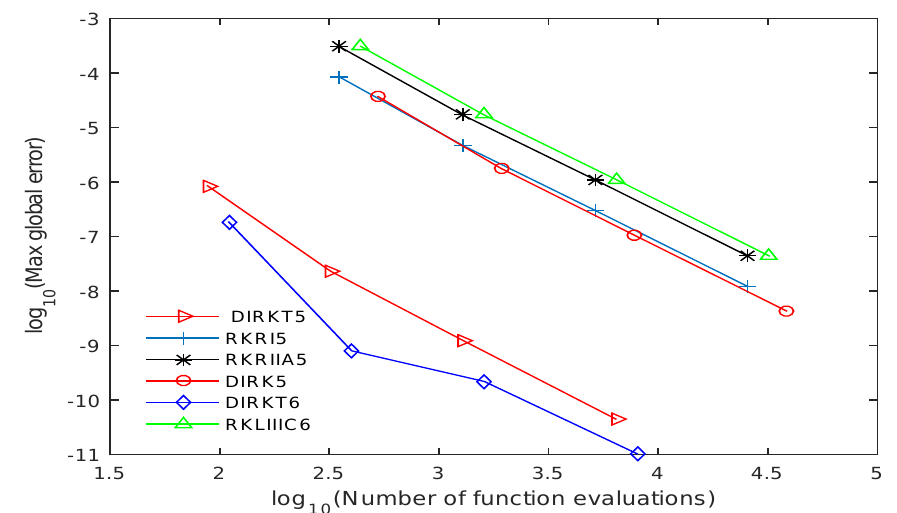
Figure 5. Accuracy curve for DIRKT5, DIRKT6, DIRK5, RKRI5, RKRIIA5 and RKLIIIC6 methods for a Beam on Elastic Foundation with h =